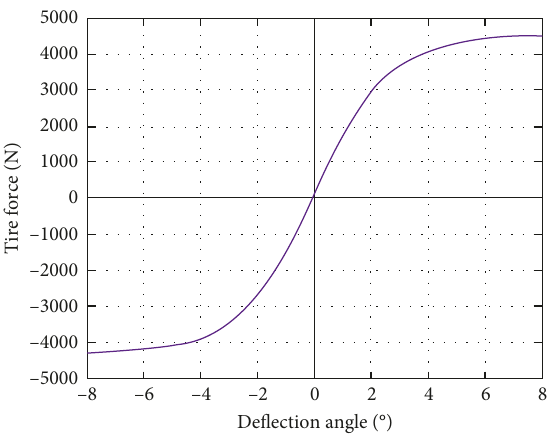
Figure 1: Tire force-deflection